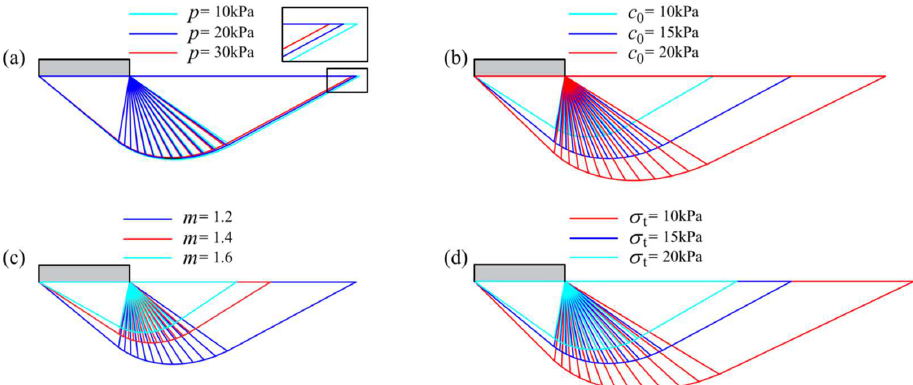
s p c m , 0 , , and t . ( a ) Effects of p. ( b ) Effects of